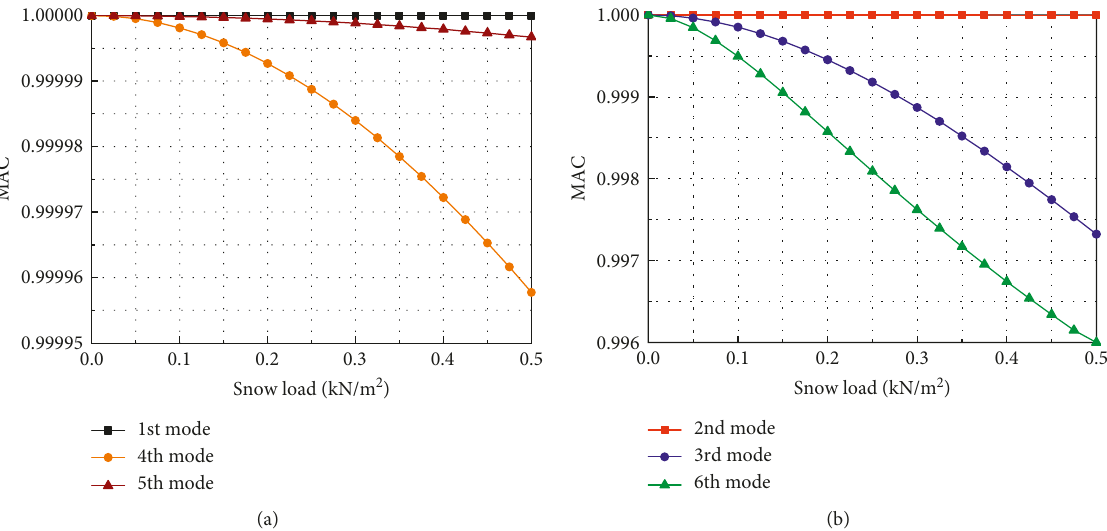
Figure 25: MAC values of the mode shapes on longitudinal direction under uniformly distributed snow load: (a) the 1st, 4th, and 5th modes and (b) the 2nd, 3rd, and 6th modes.